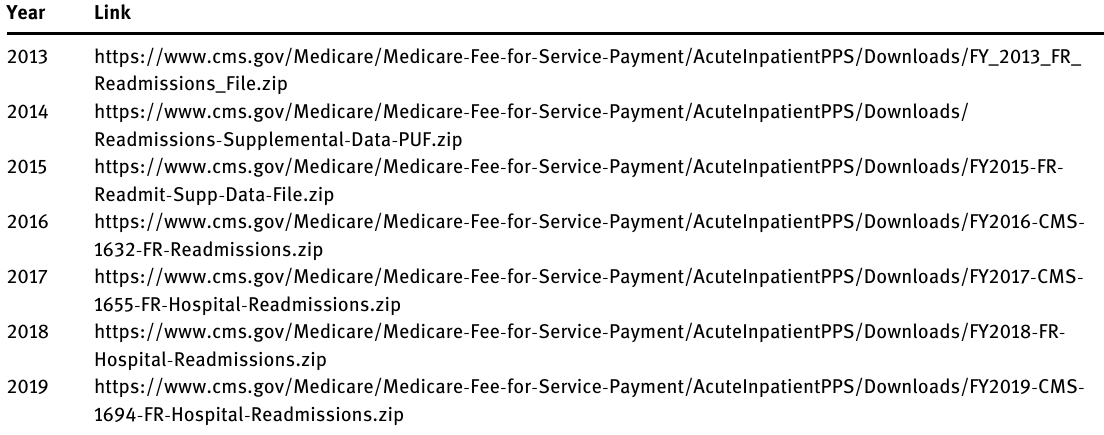
Table A6: Download links for the HRRP data Year Link